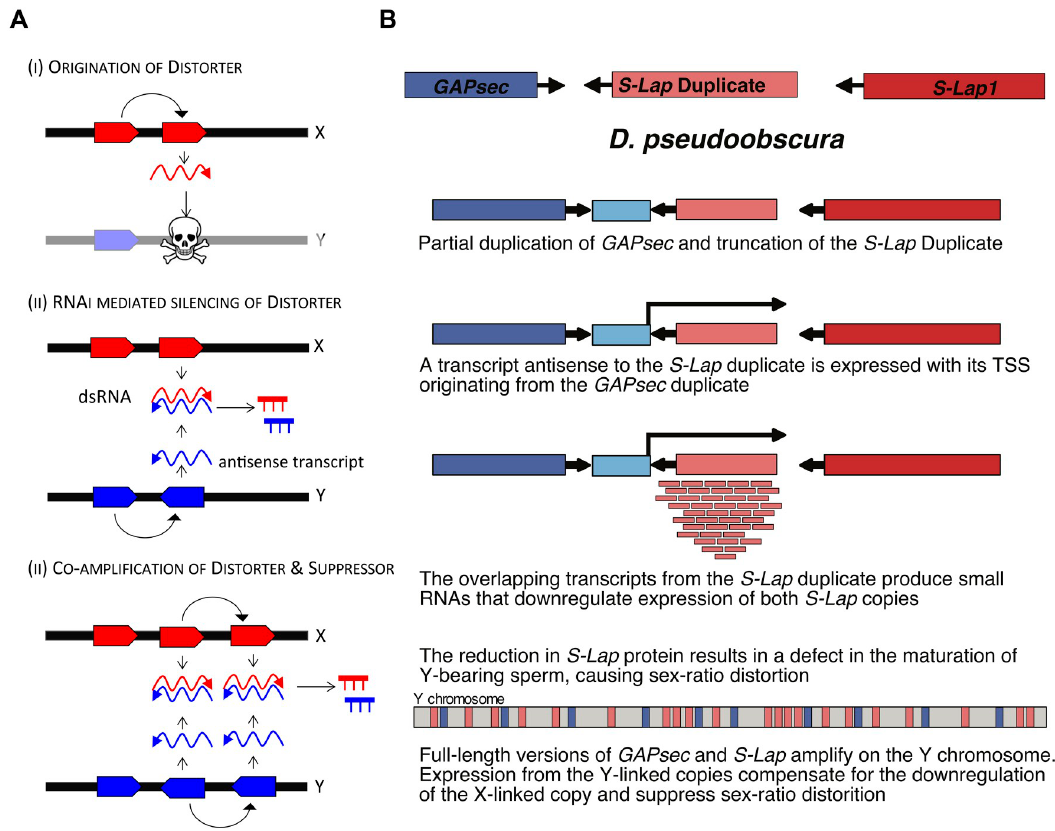
Fig 6. Meiotic conflict could fuel co-amplification of X and Y genes. A . A hypothetical model that may account for co- amplification of X- and Y genes and small RNA production invoking recurrent sex chromosome drive. An X-linked gene duplicate can evolve a novel function that eliminates Y bearing sperm. Amplification of the homologous Y gene, and production of antisense transcript may trigger the RNAi response, and silence the distorter. Repeated cycles of amplification of dosage-sensitive distorters and suppressors can result in the co-amplification of X/Y genes that are targeted by short RNAs. B . A hypothetical evolutionary model of the cryptic S-Lap1 drive system. S-Lap1 was duplicated in an ancestor of D . pseudoobscura , and a partial duplication of GAPsec created a TSS for anti-sense transcription of S-Lap1 duplicate. Production of small RNA’s may deplete S-Lap1 transcripts, which may result in elimination of Y-bearing sperm, and could be compensated by amplification of S-Lap1 on the Y